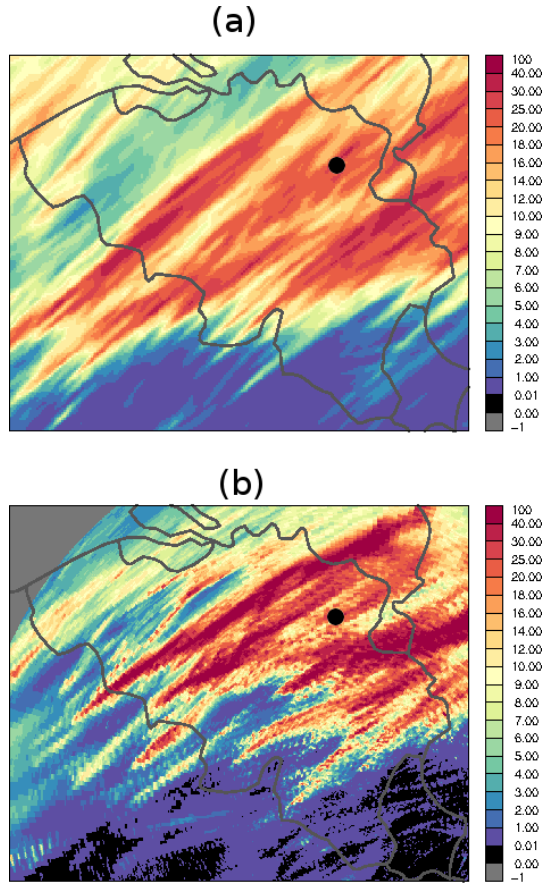
Figure 9. The accumulated precipitation between + 6 and + 30h forecast range (a) simulated by ALARO and (b) observed with the radar of Wideumont,